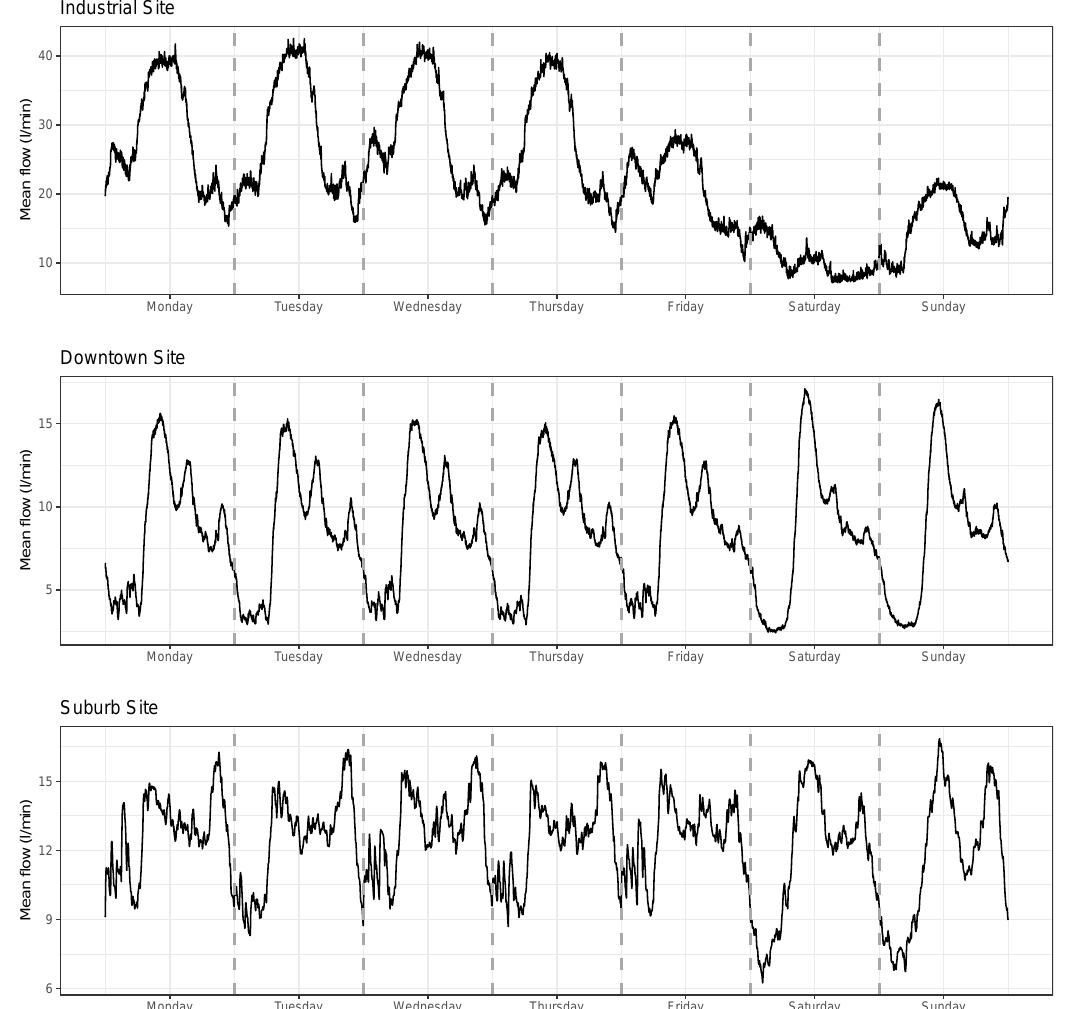
Figure A1. Mean flow vs. day of the week. For each of the three sites, the average for each minute of each weekday is